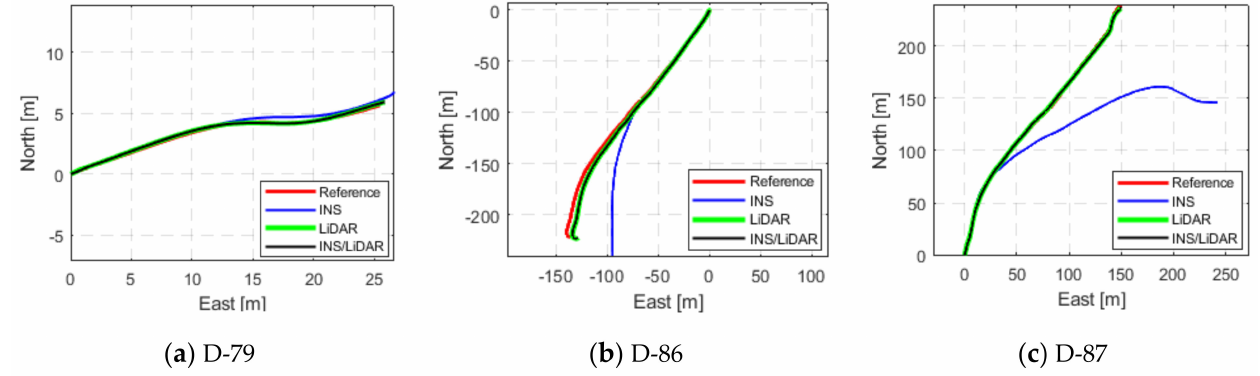
Figure 11. Complete GNNS signal outage: comparison of trajectories (D-79 to D-87).